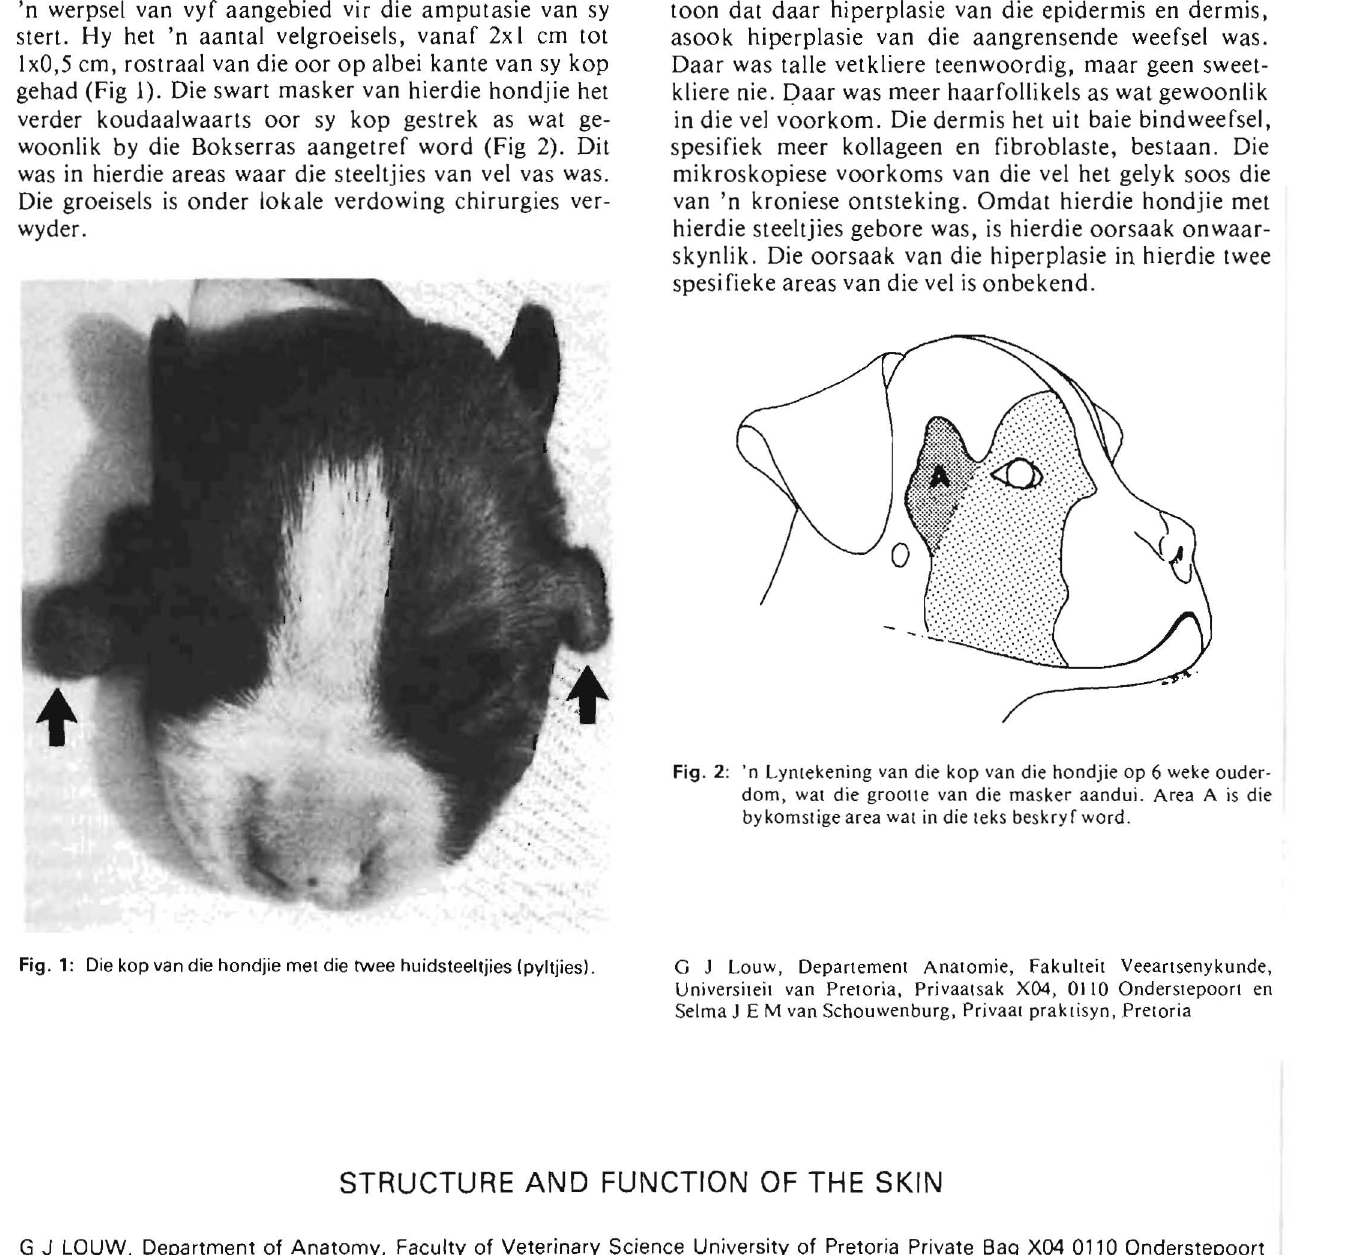
Fig. 1: Die kop van die hondjie met die !Wee huidsteeltjies (pyltjiesl.